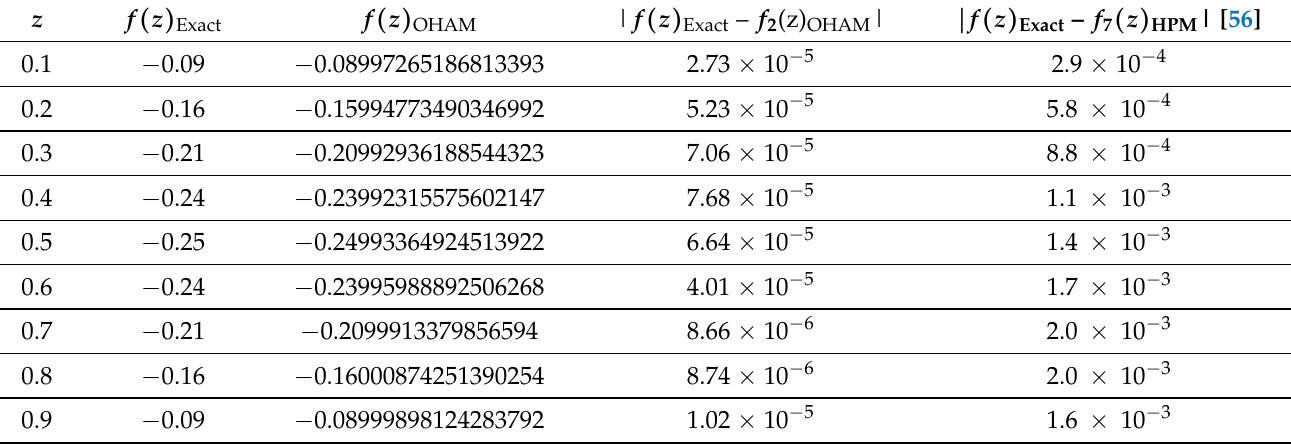
Table 3. Absolute error comparison of exact solutionswith 2nd order OHAM solutions of f ( z ) and 7th order solutions of